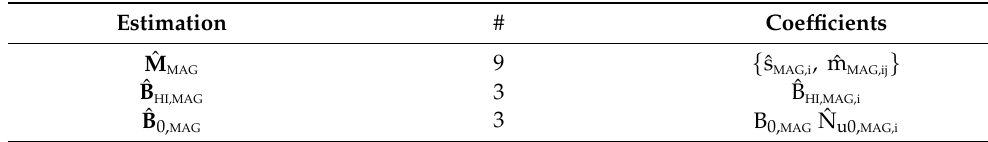
Table 11. Results of swinging